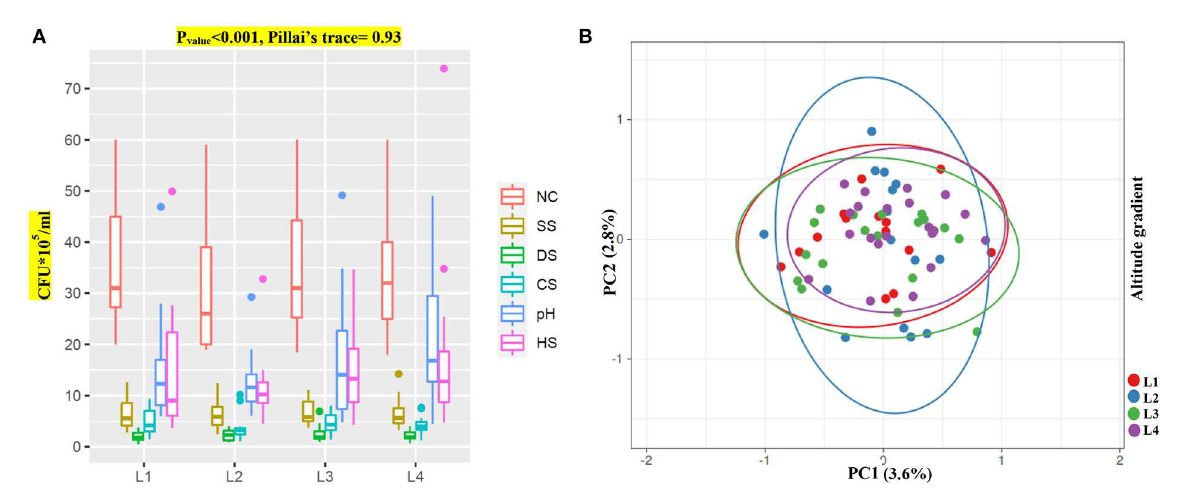
FIGURE3 Bacteria growth along an elevational gradient. (A) Growth response of bacteria isolates (CFU*10 5 /ml) from different altitudes to NC (normal condition, F value = 0.19) and environmental stresses SS (salt stress, F value = 0.04), DS (drought stress, F value = 0.32), CS (cold stress, F value = 0.73), pH (pH stress, F value = 1.55) and HS (heat stress, F value = 0.60). (B) PCA analysis of altitude gradient on bacterial